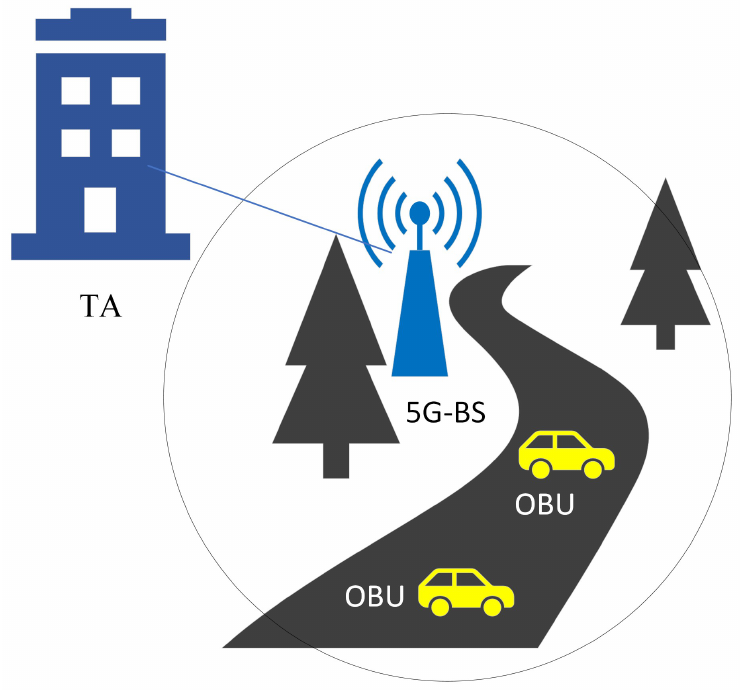
Figure 1. The system model of our